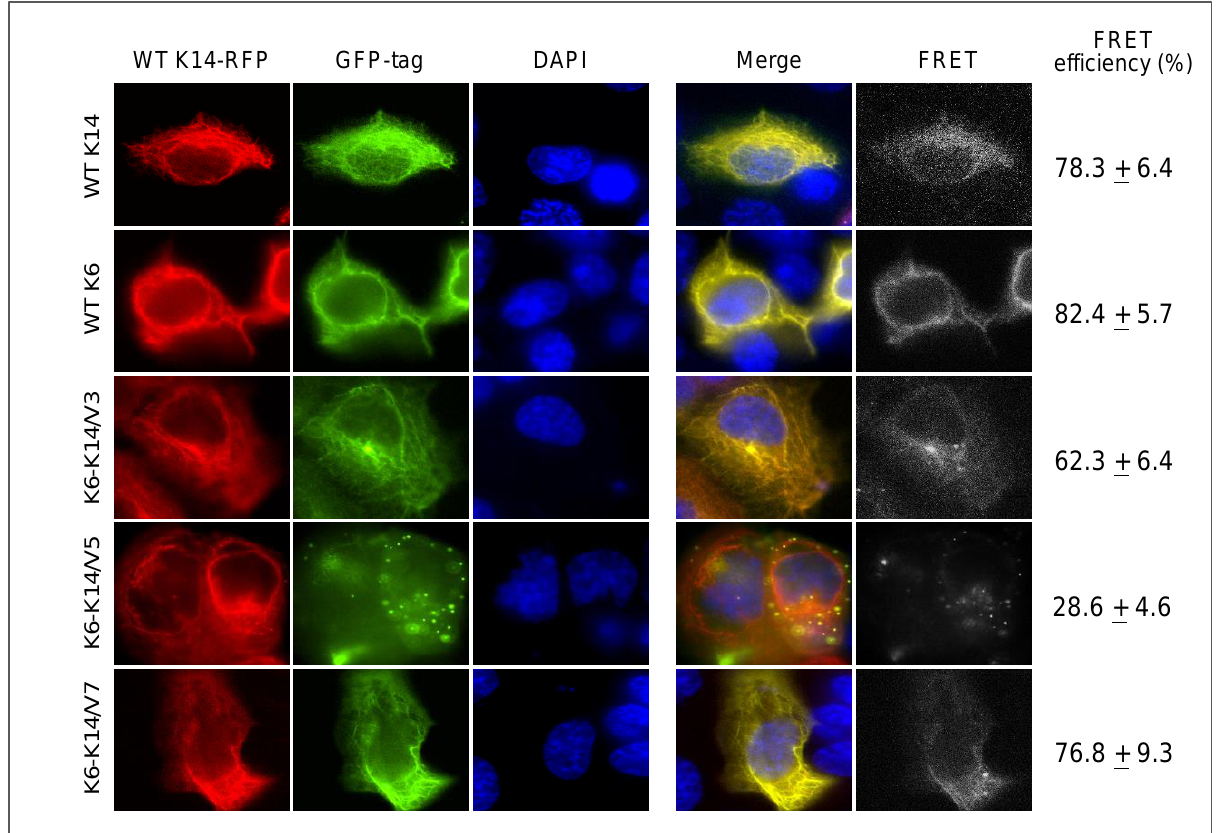
Figure 2. Functional impacts of cytokeratin fusion variants on wild-type (WT) K14 networks. K6-K14 cytokeratin fusion variants (tagged with GFP) and WT K14 (tagged with mCherry) were cotransfected into Cal-27 oral cancer cells. Permeable DAPI was utilized to stain the nucleus (blue). WT K6 and WT K14 tagged with GFP were utilized as reference controls. The representative images were taken 36 h after transfection. The interaction between each fusion variant and WT K14 was analyzed by fluorescence resonance energy transfer (FRET) assay. These data were reproduced from the original paper [51].